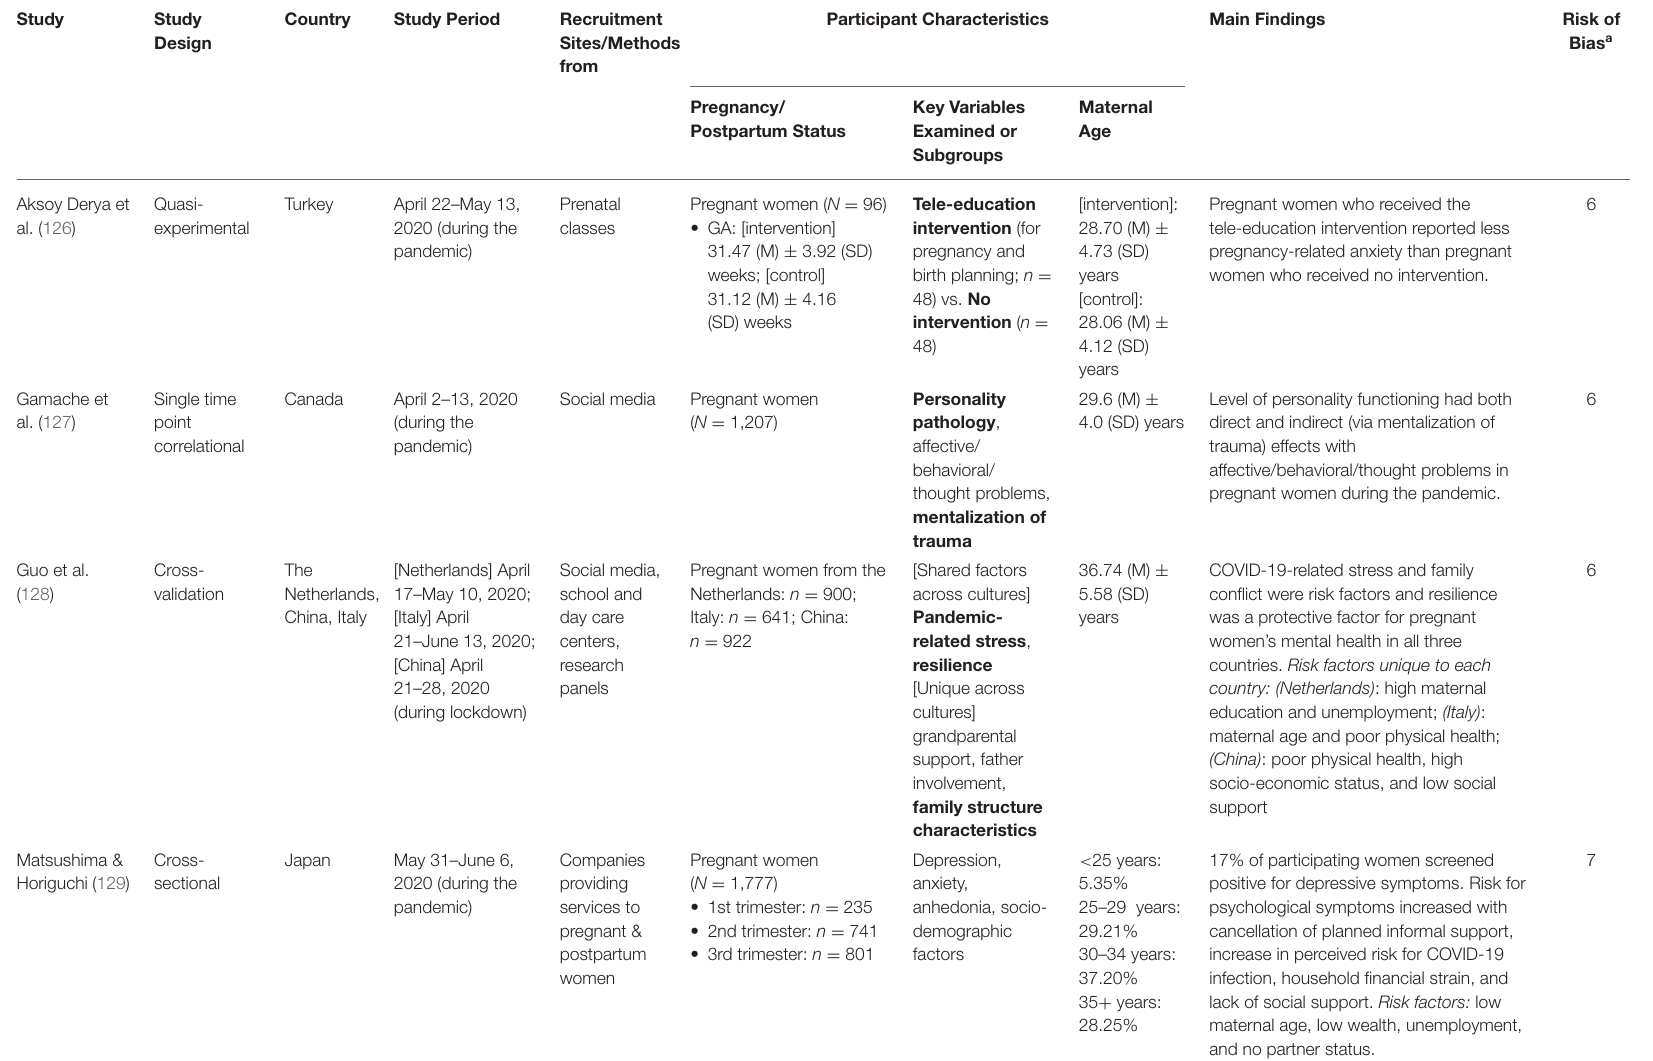
TABLE 9 | Modeling or intervention studies of perinatal mental health outcomes during the COVID-19